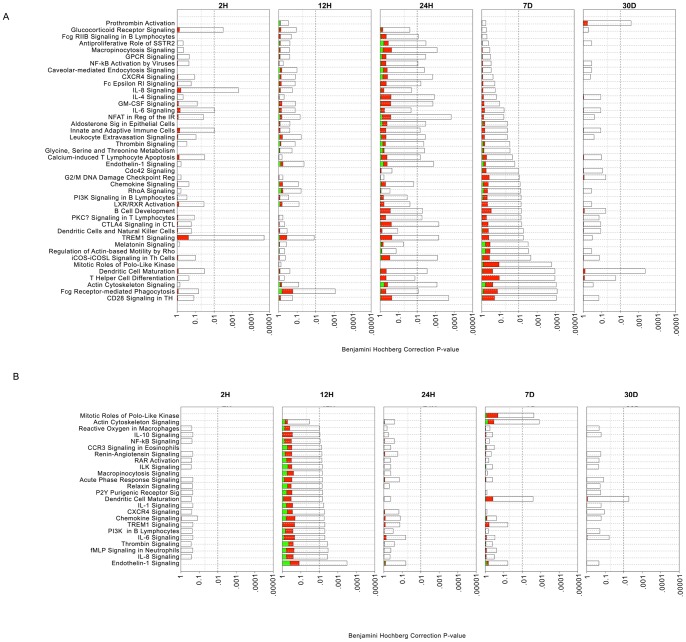
Analysis of canonical pathways enrichment in vein grafts at different time-points.A) EC, B) SMC: Each panel denotes the effect on canonical pathways at particular time-points after graft implantation. Each bar represents a pathway with significance of enrichment determined using the Benjamini-Hochberg hypothesis corrected p-value (shown on primary X-axis). The directionality of the genes in each pathway is depicted using a pseudocolor (red for up-regulated genes, green for down-regulated genes and clear for unmodified genes).